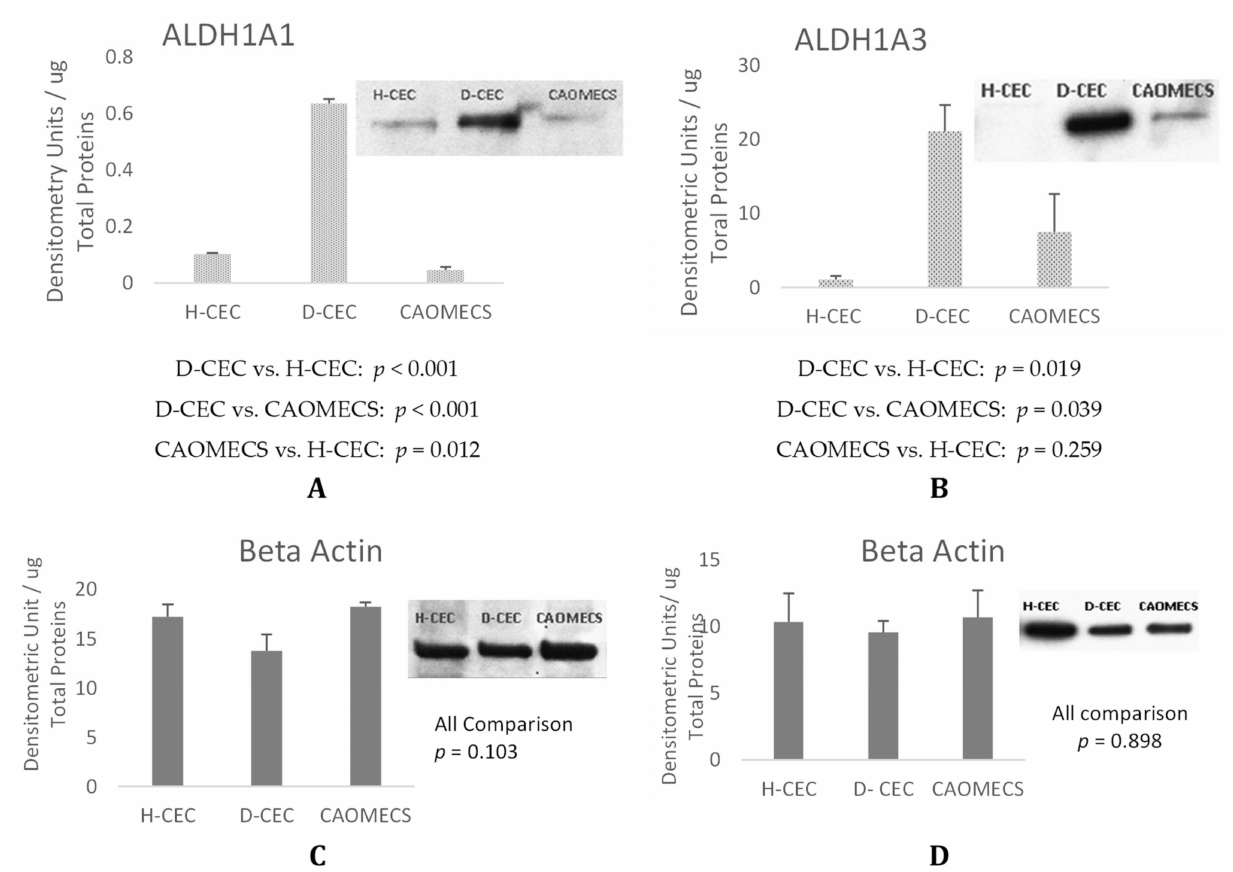
Figure 3. Expression levels of ALDH1A1 ( A ) and ALDH1A3 ( B ) in healthy CEC (H-CEC), diseased CEC (D-CEC) and in CAOMECS. Note that ALDH1A1 and ALDH1A3 were significantly increased in D-CEC as compared to H-CEC and CAOMECS. ( C , D) are beta-actin levels measurement used as the loading control for the semi quantitative measurements used in this experiment. Values are shown as Mean ± SEM, n = 3. All Pairwise Multiple Comparison Procedures were done using Student-Newman-Keuls